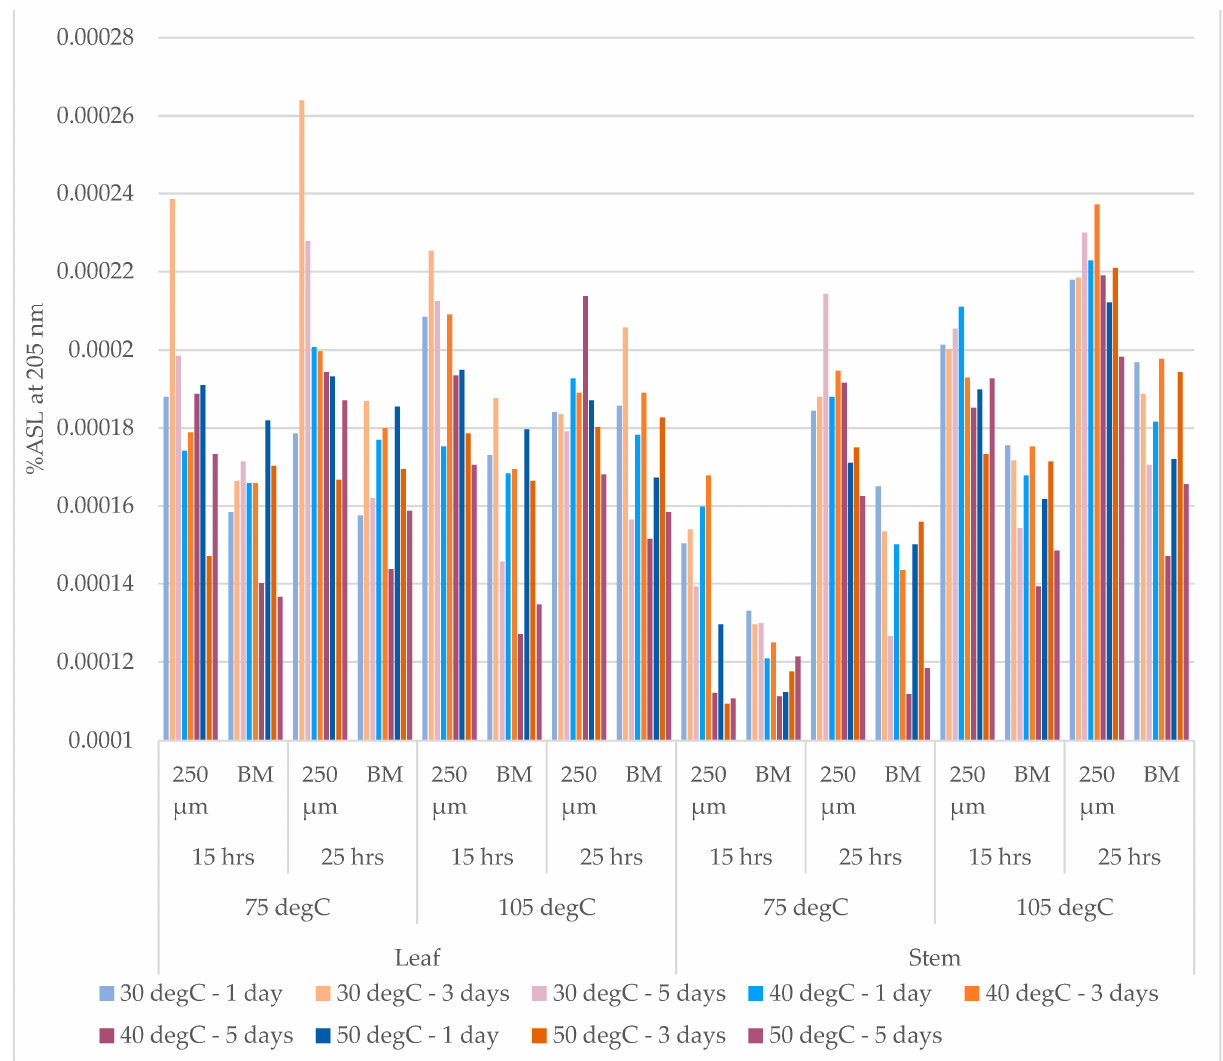
Figure 8. Soluble lignin content after enzymatic hydrolysis at 205 nm.